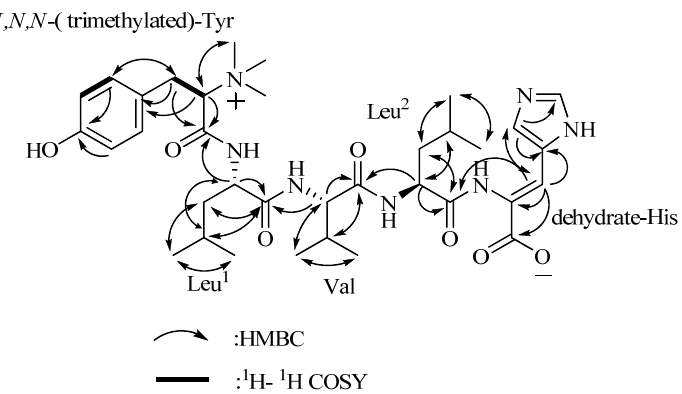
Figure 2. Selected 2D NMR correlations for 4862F.